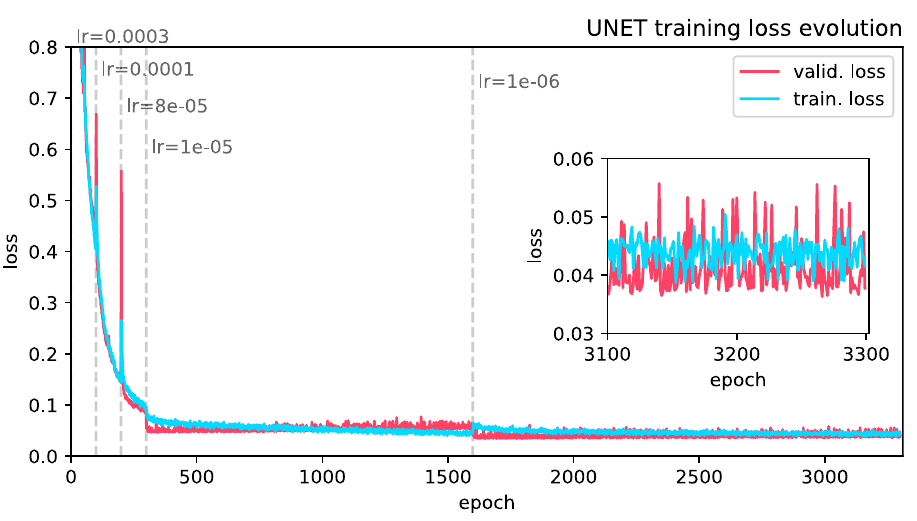
Figure 5. NN training: training and validation loss for each epoch of the training